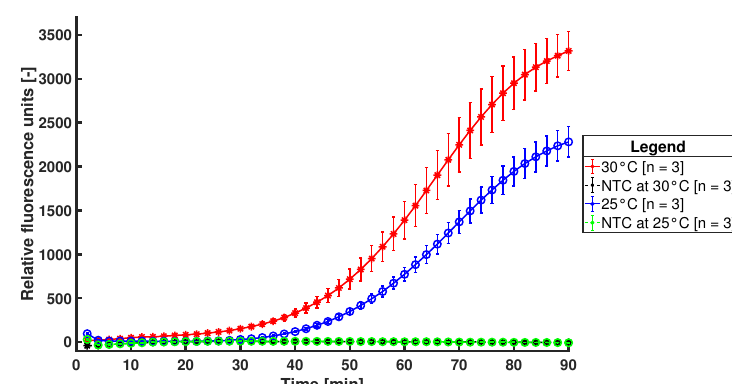
Figure 13. Fluorescence signal of MDA reactions performed at 25 ◦ C and 30 ◦ C, together with their (overlapping) NTCs.